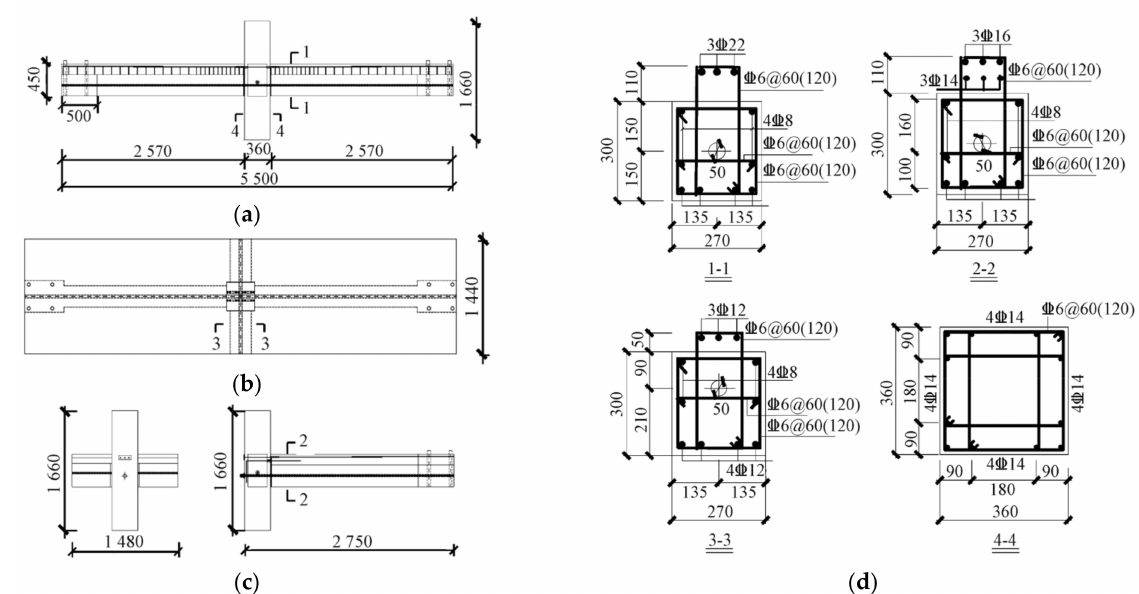
Figure 6. Size and reinforcement of the specimens from [28]: ( a ) side view of the mid-joint; ( b ) top view of the mid-joint; ( c ) side view of the edge-joint; ( d ) sectional reinforcement (dimensions in mm).